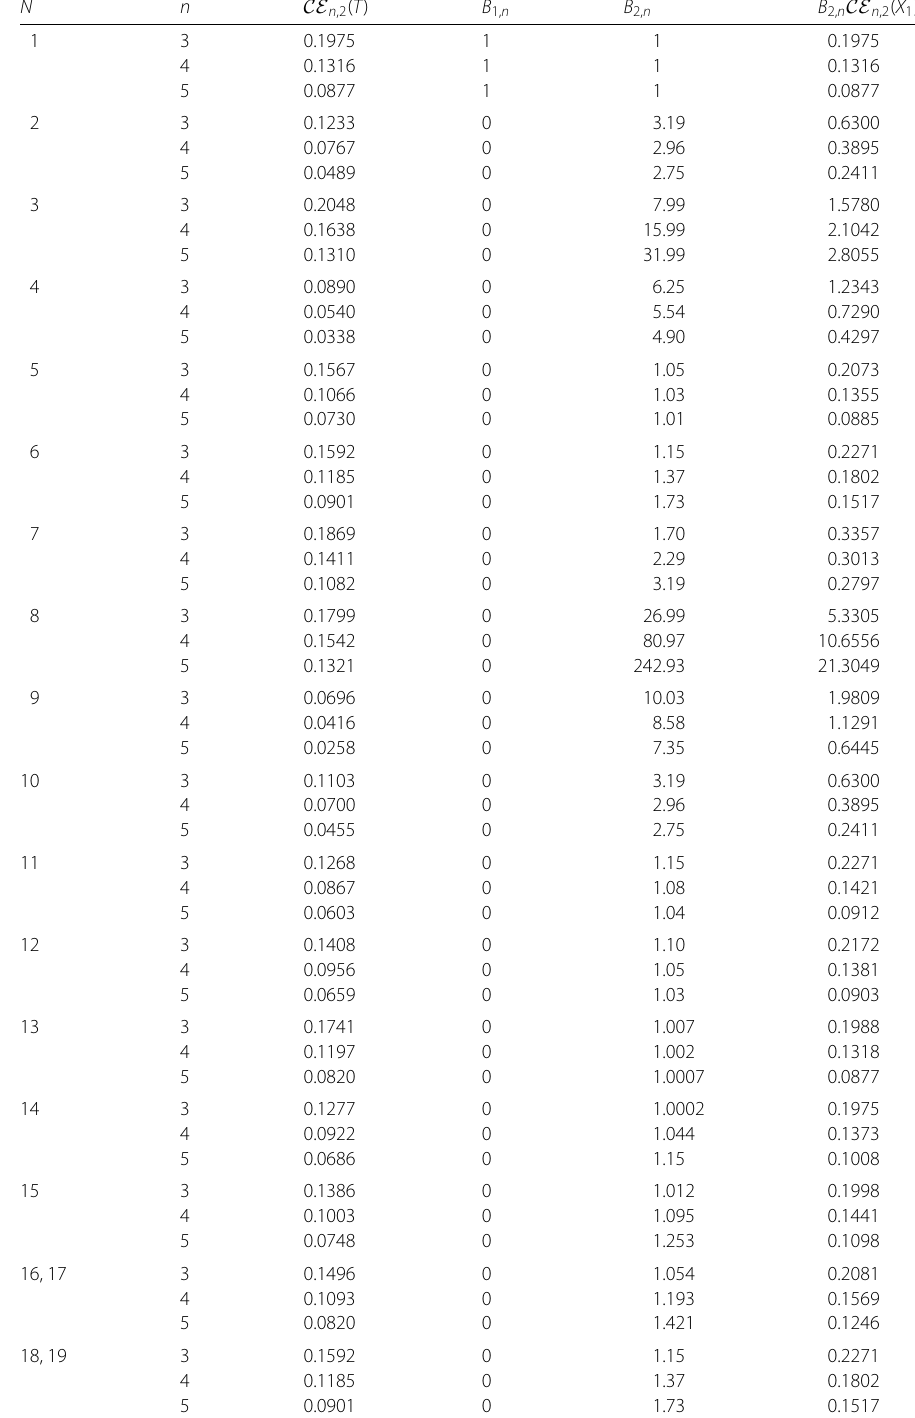
Table 2 CE n ,2 ( T ) and bounds for CE n ,2 ( T ) obtained from the coherent systems given in Table 1 with i.i.d. components having a uniform distribution in